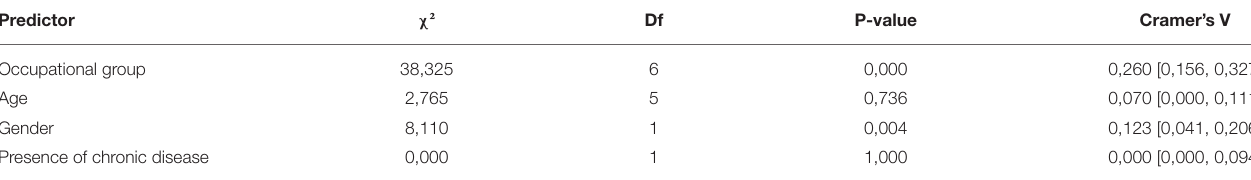
TABLE 2 | χ 2 -Test and effect size (Cramer’s V) of the stochastic relationship between predictors and vaccination decision in the influenza season 2019/20.